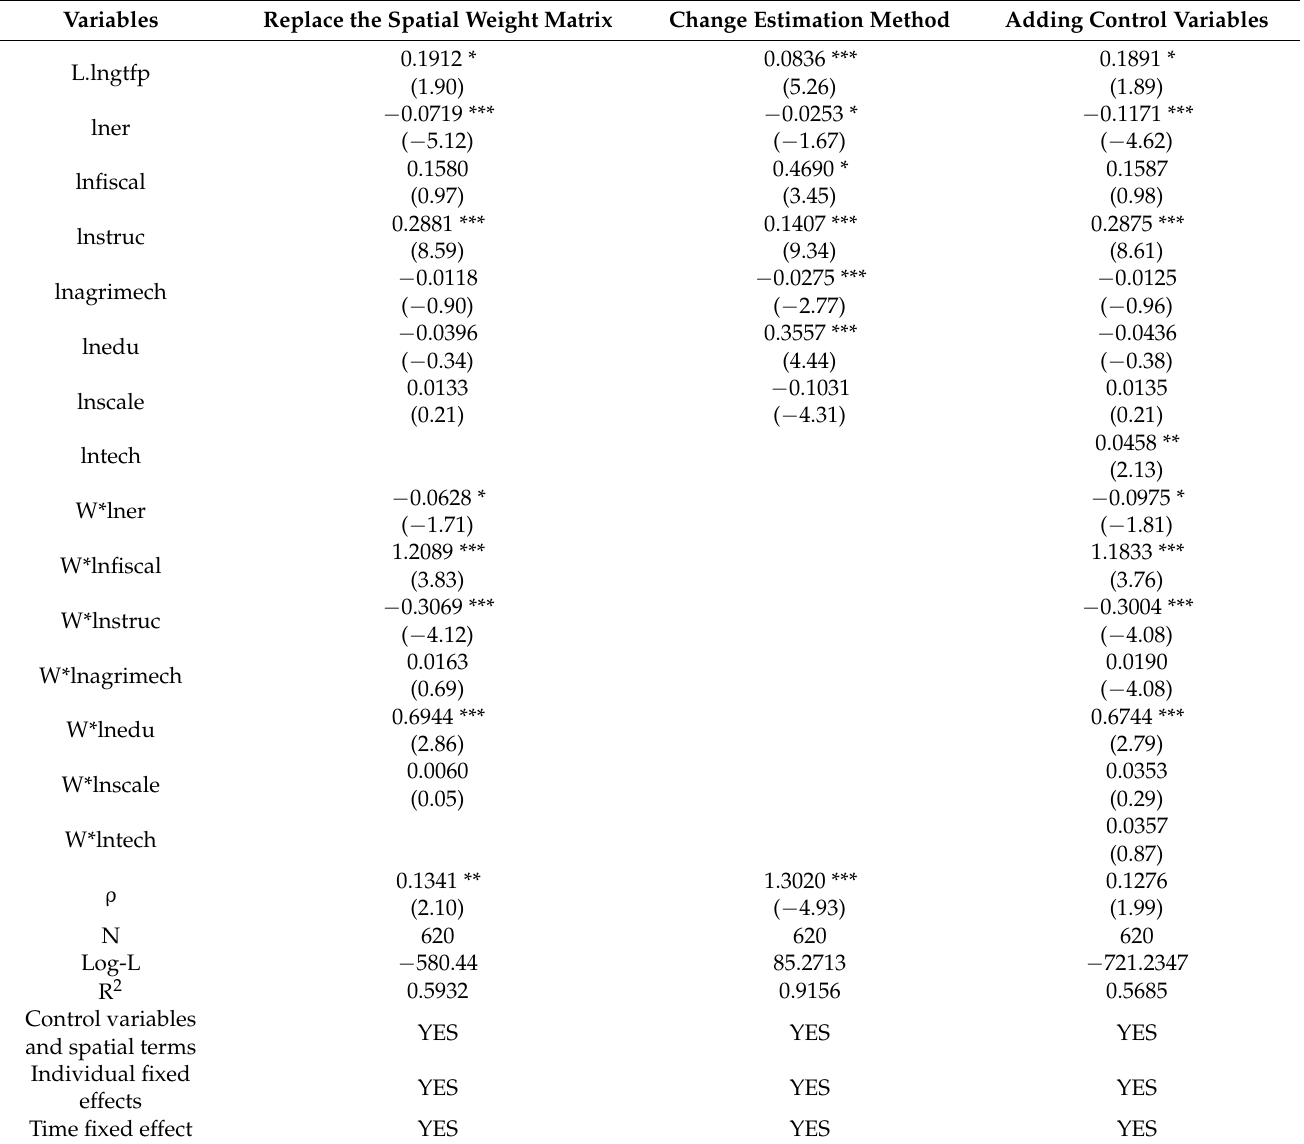
Table 7. The results of robustness